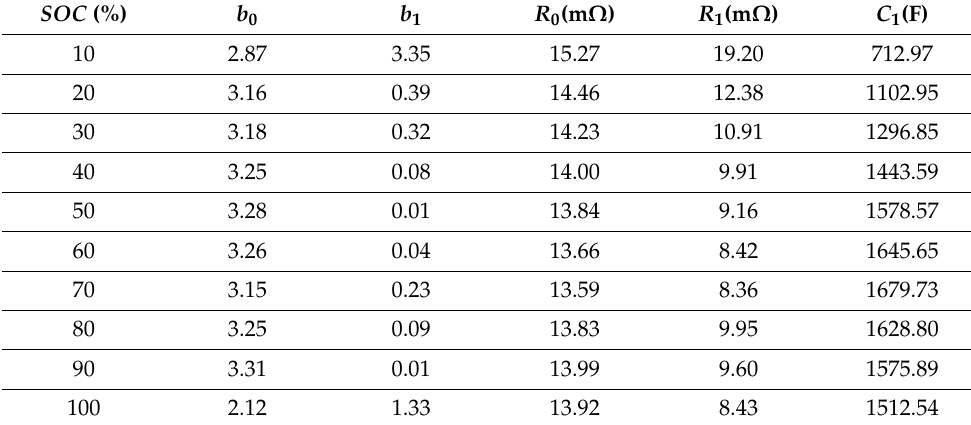
Table 7. Battery parameters at all SOC points, estimated with the two-outputs nonlinear grey box